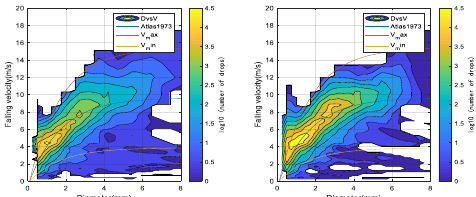
Figure 1. Particles diameter–velocity distribution in Zhanjiang and Suixi